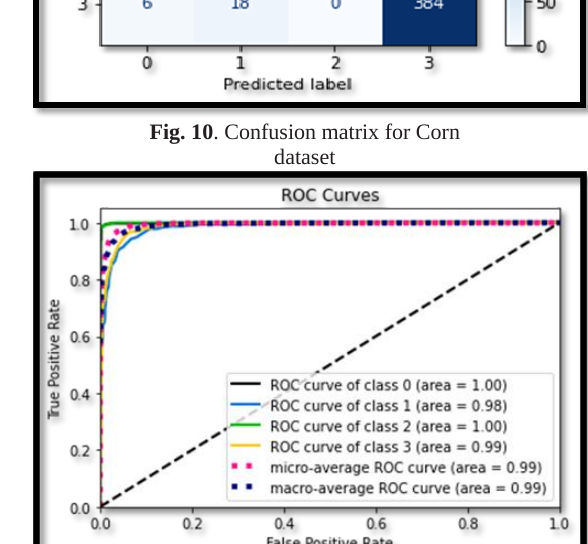
Fig. 7. ROC curve on potato dataset